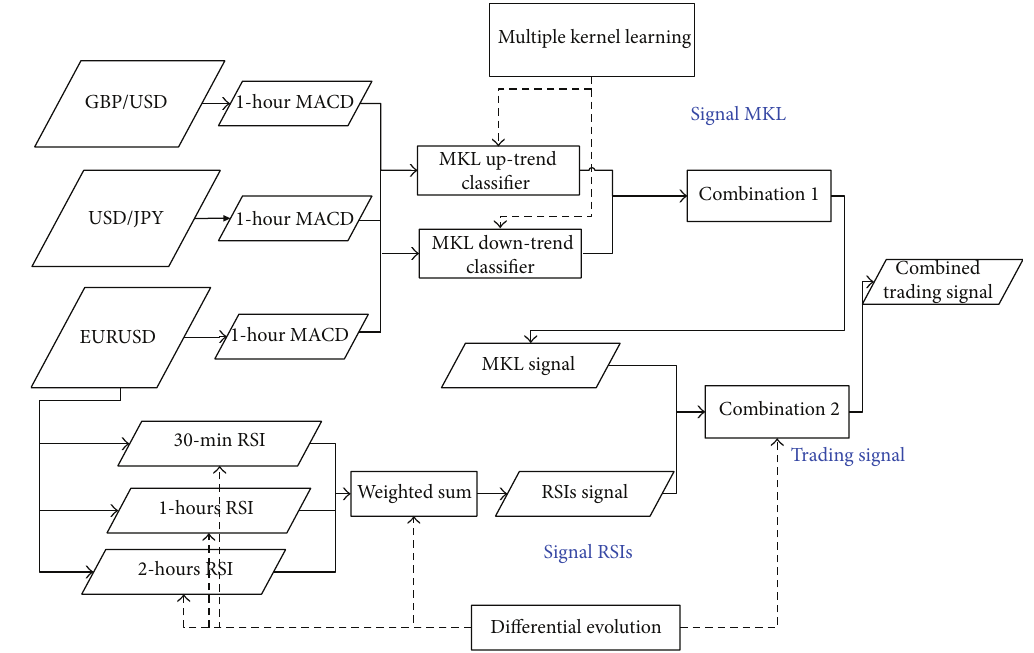
Figure 2: Structure of the proposed method.